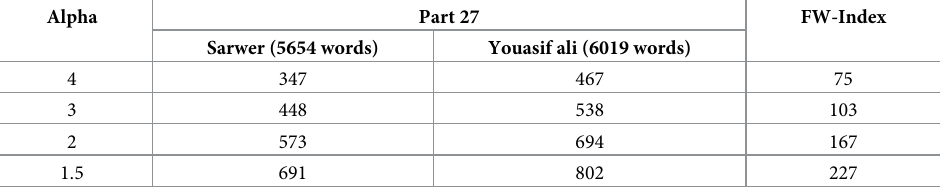
Table 3. Affection of choosing alpha on the number of words in the coincidences lists of FW-Index for two tested texts. Alpha Part 27